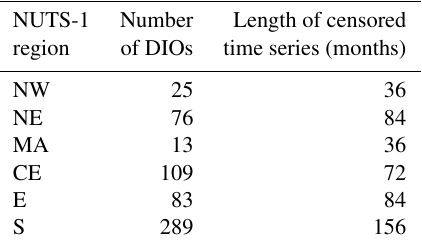
Table 2. Information on DIOs for the different sub-regions and the length of the time series for analysis for the most censoring counting method